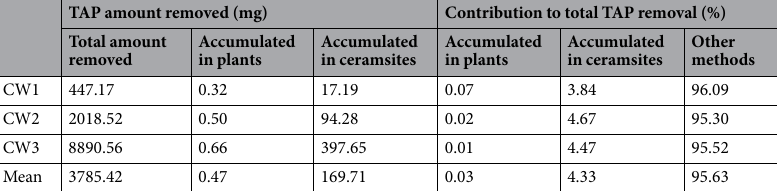
balance (Table 1). The mean percentages of the accumulation in plants and substrates for the three CWs with respect to the total TAP removal were only 0.035 ± 0.034% and 4.33 ± 0.43%, indicating that over 95% of TAP removal from each of the systems was contributed through other mechanisms.